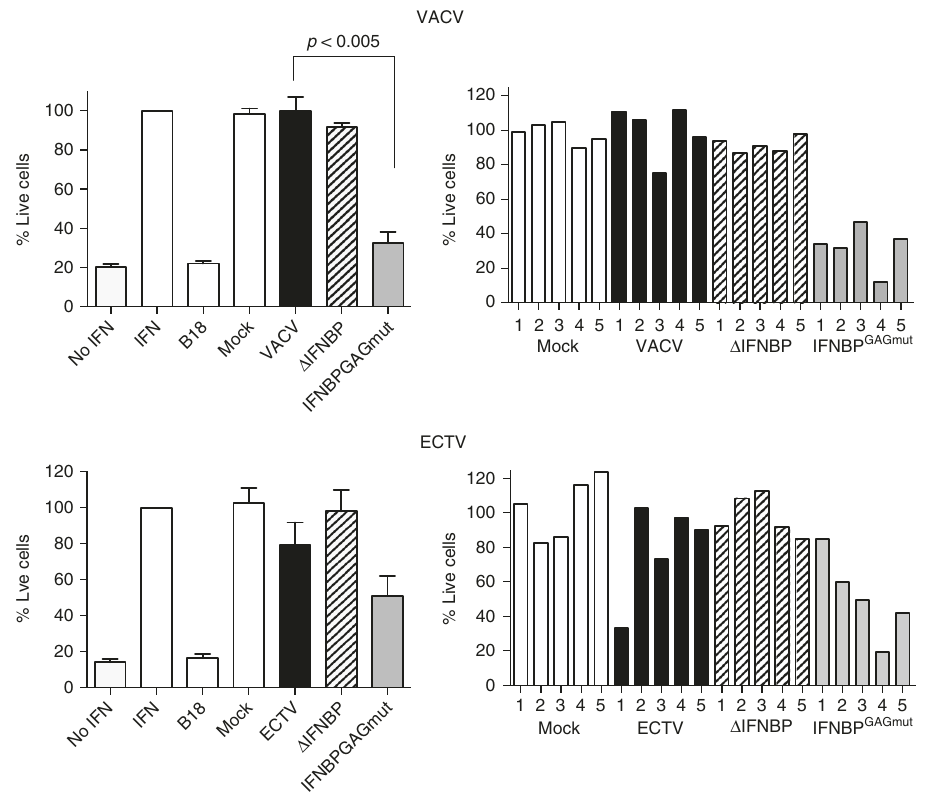
Fig. 8 Detection and biological action of the IFN α / β BP in plasma from infected animals. Dilutions containing 20% of plasma from mice infected with the indicated viruses at 5 dpi were independently incubated with 50 U of human IFN α A for VACV samples or 50 U of mouse IFN α A for ECTV samples, and then added to HeLa or L929 cells, respectively. After 16 h cells were infected with VSV and cell viability measured at 72 hpi to determine the IFN blocking activity from plasmas. Mean±SEM from a representative experiment in triplicate from two with 5 mice/group is shown in the left panels, while the corresponding individual values obtained for each mouse are shown in the right